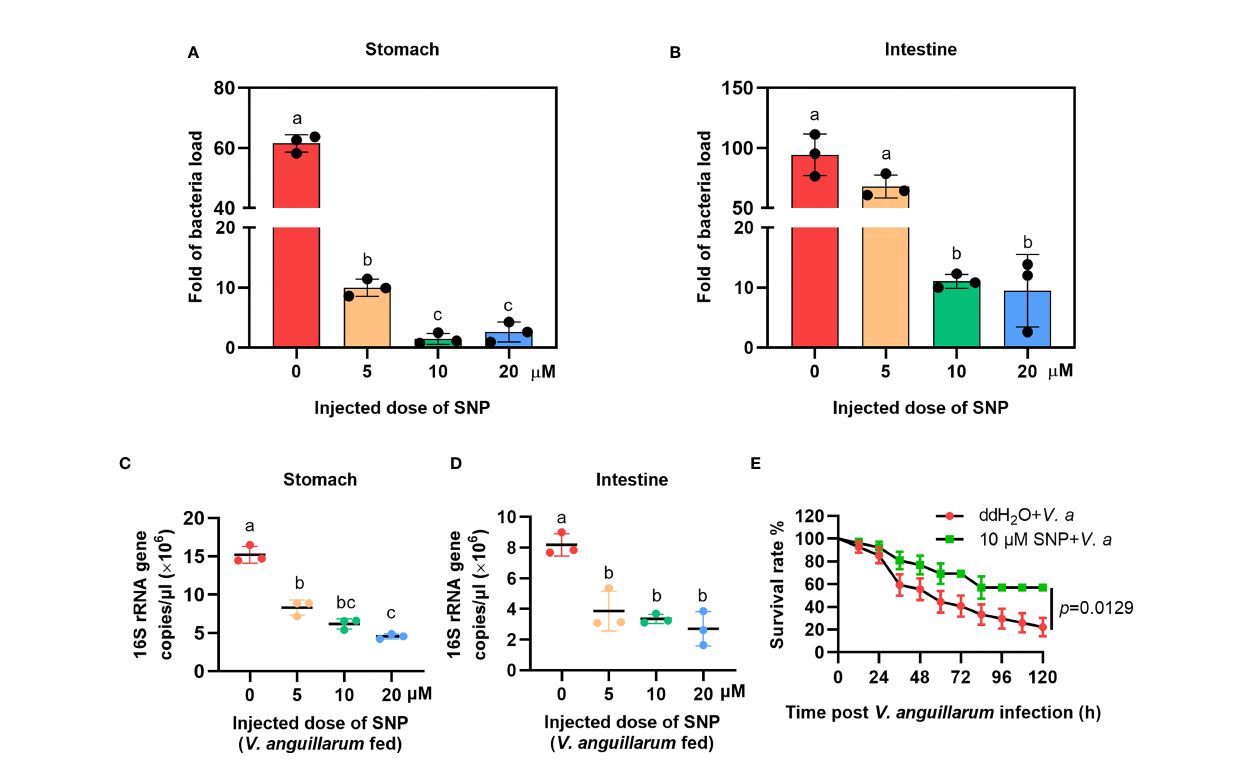
FIGURE 4 | The bacterial load decreased in the gastrointestinal track of shrimp after SNP treatment. (A) The bacteria load in the stomach of SNP-treated shrimp. (B) The bacteria load in the intestines of SNP-treated shrimp. (C) The 16S rRNA gene copies in the stomach of SNP- and V. anguillarum cotreated shrimp. (D) The 16S rRNA gene copies in the intestines of SNP- and V. anguillarum cotreated shrimp. (E) Survival rate of shrimp injected with 10 m M SNP following V. anguillarum infection; ddH2O + V. anguillarum -injected shrimp were used as the control. One-way ANOVA was used for multiple comparisons, the different lowercase letters indicate signi fi cant differences ( p < 0.05) in the ANOVA